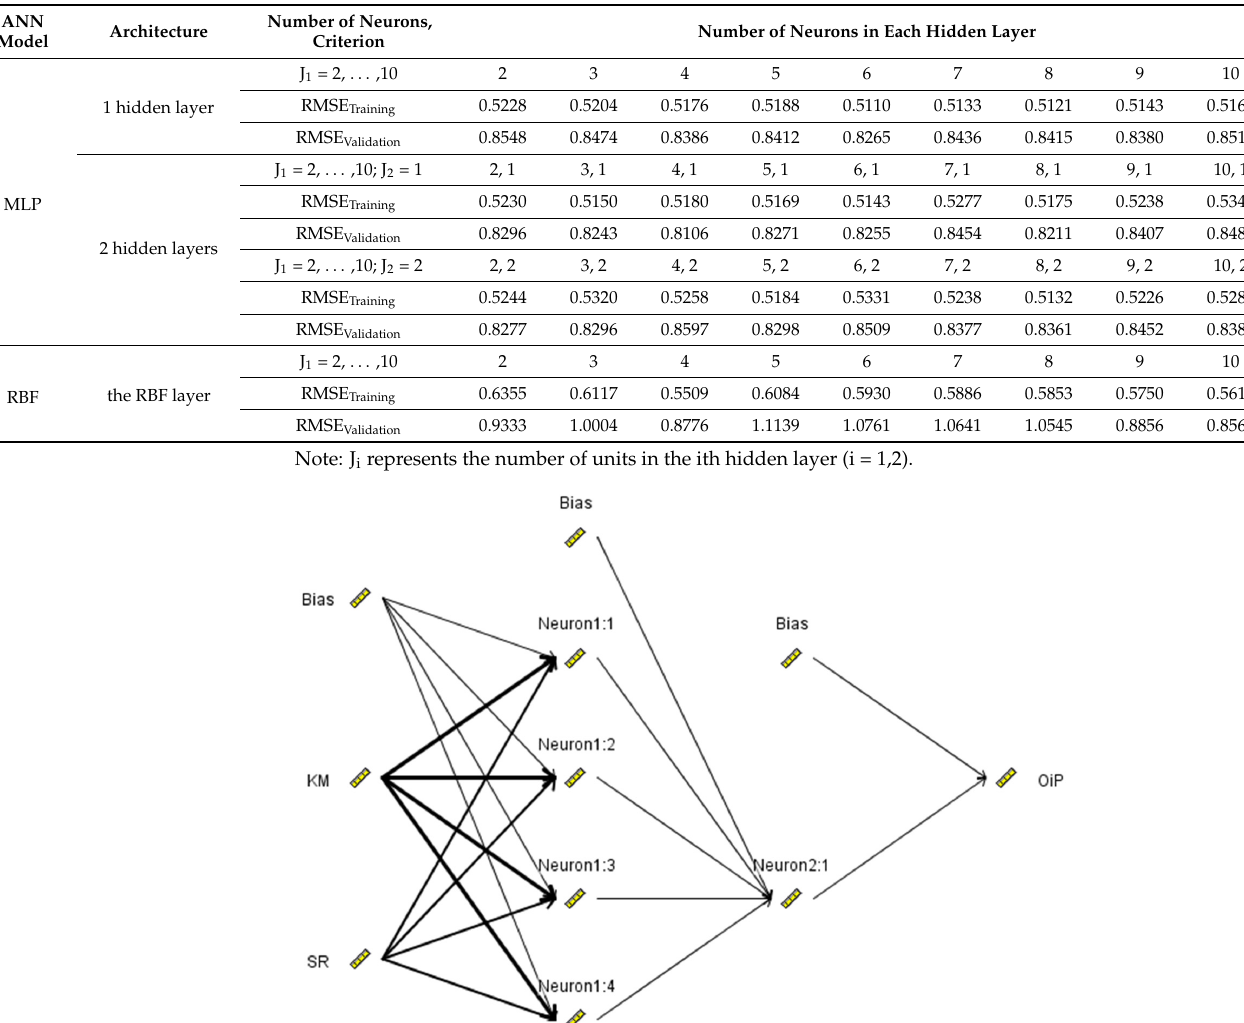
Table 10. Variation of the RMSE statistics of the MLP and RBF networks with the number of neurons in each hidden layer.